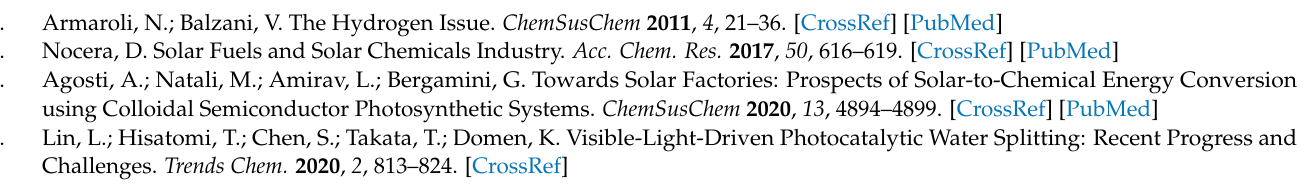
SCE while the Pt-based collector was held at +0.2 V vs. SCE. Figure S21. CA at − 0.2 V vs. SCE chopped irradiation. Figure S22. CA at − 0.2 V vs. SCE of NiO-B| P1 |Pt- 2 at different deposition times in N 2 -purged 0.1 M acetate buffer at pH 4 under chopped irradiation. Figure S23. CA at − 0.2 V vs. SCE of NiO-B| P1 |Pt- n with n = 3–5 in N 2 -purged 0.1 M acetate buffer at pH 4 under chopped irradiation. Figure S24. LSV of NiO-B| P1 |Pt- 1 at different deposition times in N 2 -purged 0.1 M acetate buffer at pH 4 under chopped irradiation. Figure S25. LSV of NiO-B| P1 |Pt- 2 at